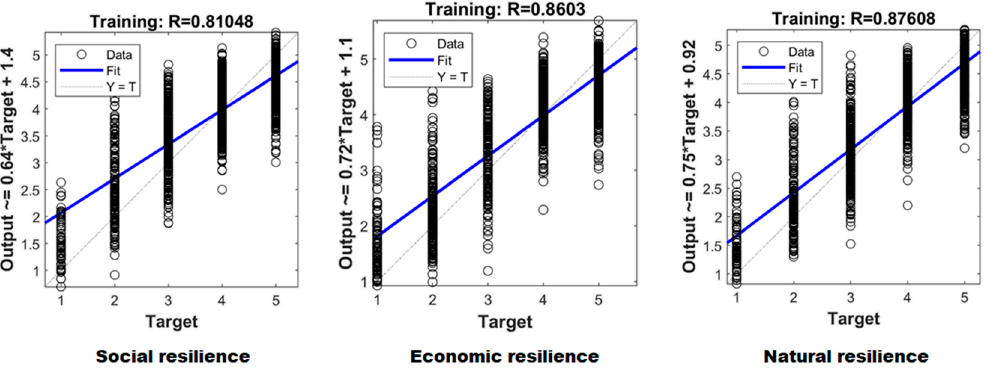
Figure 8. Training fit degree of social, economic, and natural resilience.